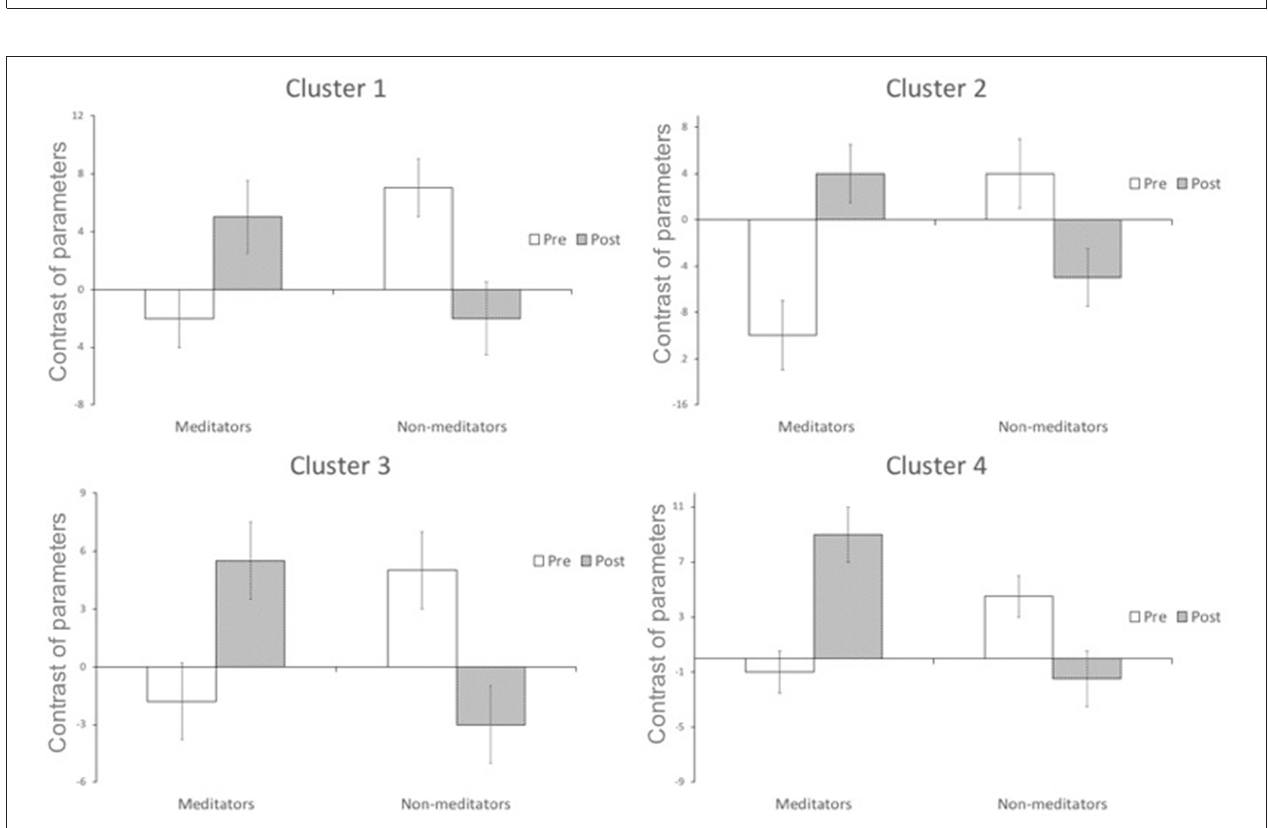
(Dahl et al., 2015). In Zen, it is emphasized the practice of attention during daily activities. The practitioner is trained to keep awareness on the impulses and be able to regulate the responses to external and internal stimuli (Austin, 2013).